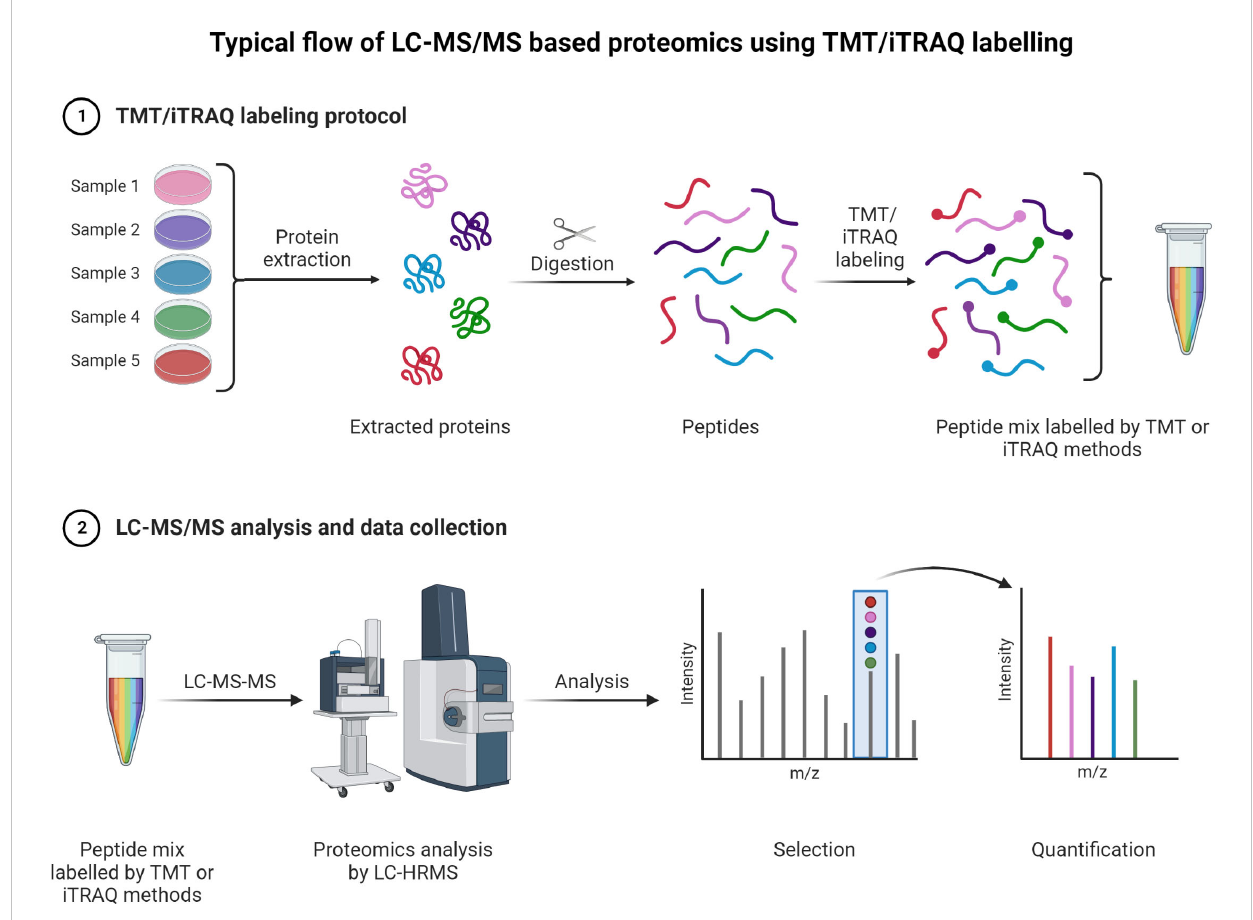
FIGURE 9 TMT or iTRAQ labeling is used to perform multiplexed (up to 18-plex) analysis for simultaneous quanti fi cation of proteins and identi fi cation (149, 150) (151, 152). Proteins are extracted and digested with respective enzyme(s). The peptides are labeled with TMT or iTRAQ multiplexed (up to 18-plex) reagents and mixed pool of TMT or iTRAQ labeled peptides are analyzed LC-MS (153 –